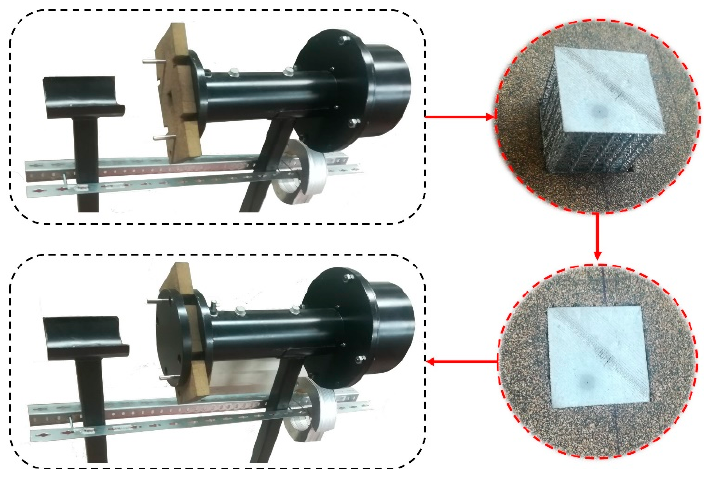
Figure 3. Detail of impedance tube and sample assembly for sound absorption